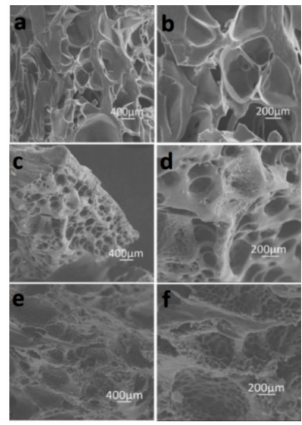
Figure 3. Scanning electron microscopy (SEM) images of hydrogels: ( a , b ) Agar / PAA hydrogel; ( c , d ) PAA / HEC hydrogel; ( e , f ) Agar / PAA / HEC